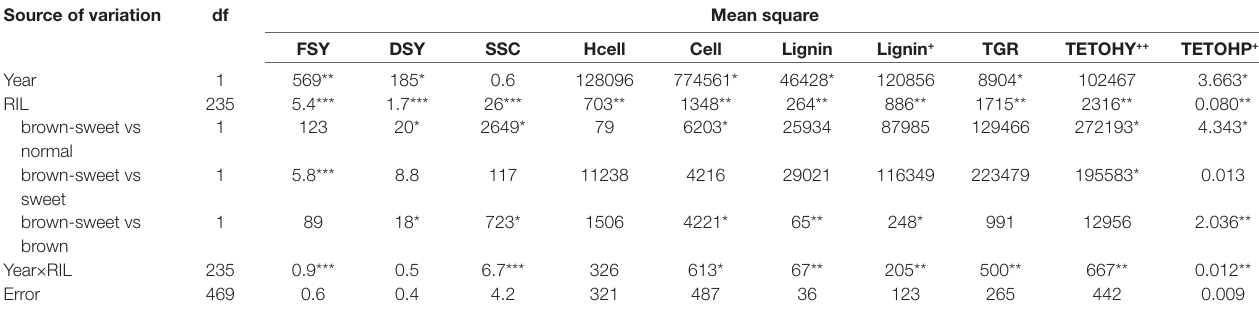
TABLE 2 | Analysis of variance (ANOVA) for biomass compositional traits, and theoretical ethanol traits of brown midrib × sweet sorghum lines over two years. Source of variation df